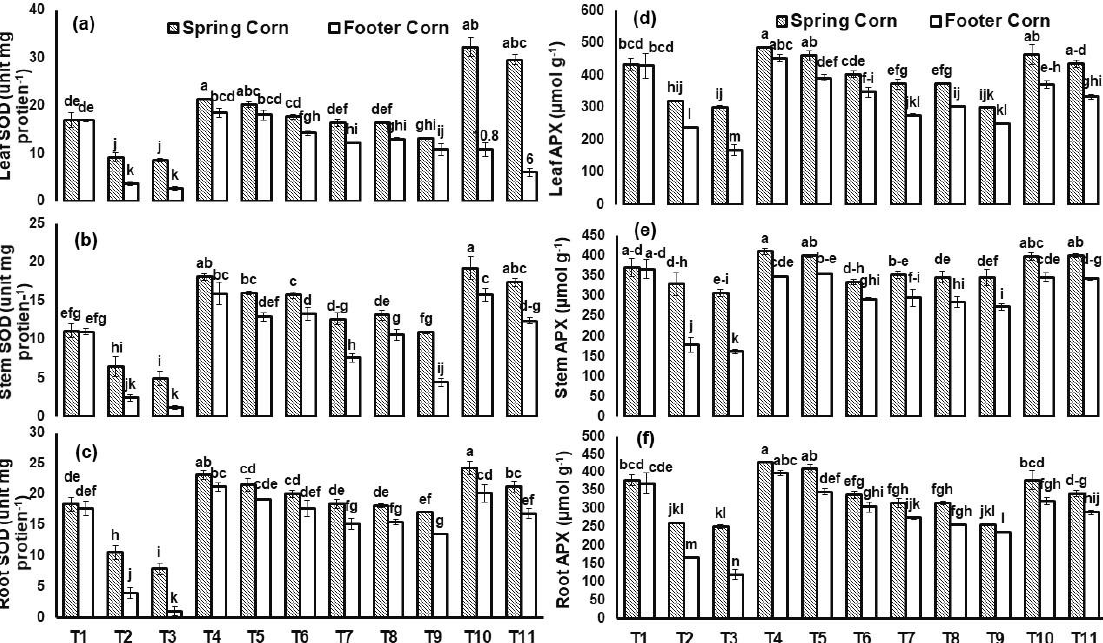
Figure 7. Superoxide dismutase (SOD- (unit mg protein − 1 ) in ( a ) leaf, ( b ) stem and ( c ) root and ascorbate peroxidase (APX- (µmol g − 1 ) in ( d ) leaf, ( e ) stem and ( f ) root of Zea mays L. plant grown in heavy-metal-contaminated soil under different treatments such as T1 = Control; T2 = Cu (300 ppm); T3 = Ni (100 ppm); T4 = F2; T5 = BC (2%); T6 = F2 + Cu (300 ppm); T7 = F2 + Ni (100 ppm); T8 = BC (2%) + Cu (300 ppm); T9 = BC (2%) + Ni (100 ppm); T10 = F2 + BC (2%) + Cu (300 ppm) and T11 = F2 + BC (2%) + Ni (100 ppm). Values are the average of three replicates ± standard error (SE). Mean bars sharing similar lower-case alphabetic letters were non-significant ( p < 0.05) to each other while different letters represented significant difference declared by one-way ANOVA using LSD test at p ≤ 0.05.